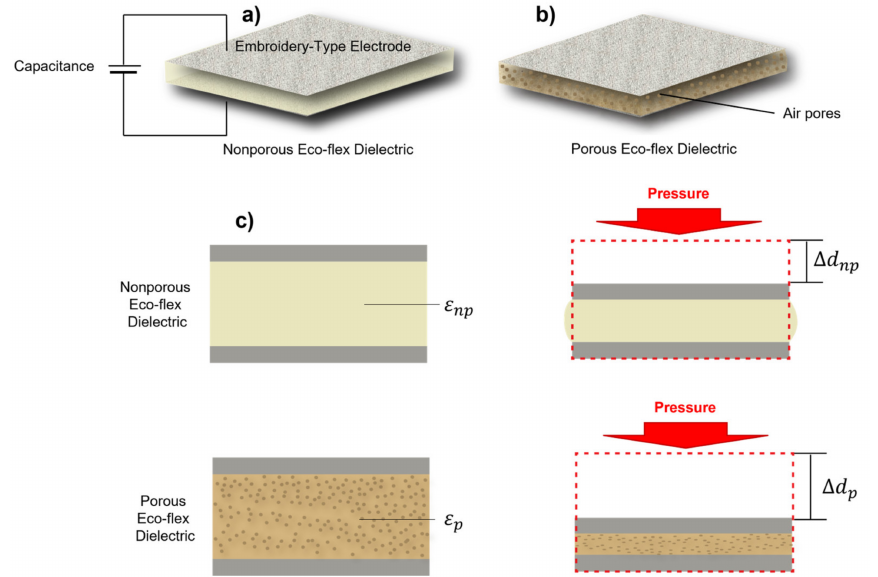
Figure 4. Pressure sensing mechanisms of the capacitive respiratory sensor using a nonporous eco- flex dielectric and porous Eco-flex dielectric. ( a ) Diagram showing the structural deformation of a capacitive respiratory sensor utilizing an Eco-flex dielectric layer that is nonporous. Porous is shown in ( b ). Schematic of the structural deformation of the capacitive respiratory sensor under compressive loading utilizing a nonporous, porous Eco-flex dielectric layer ( c